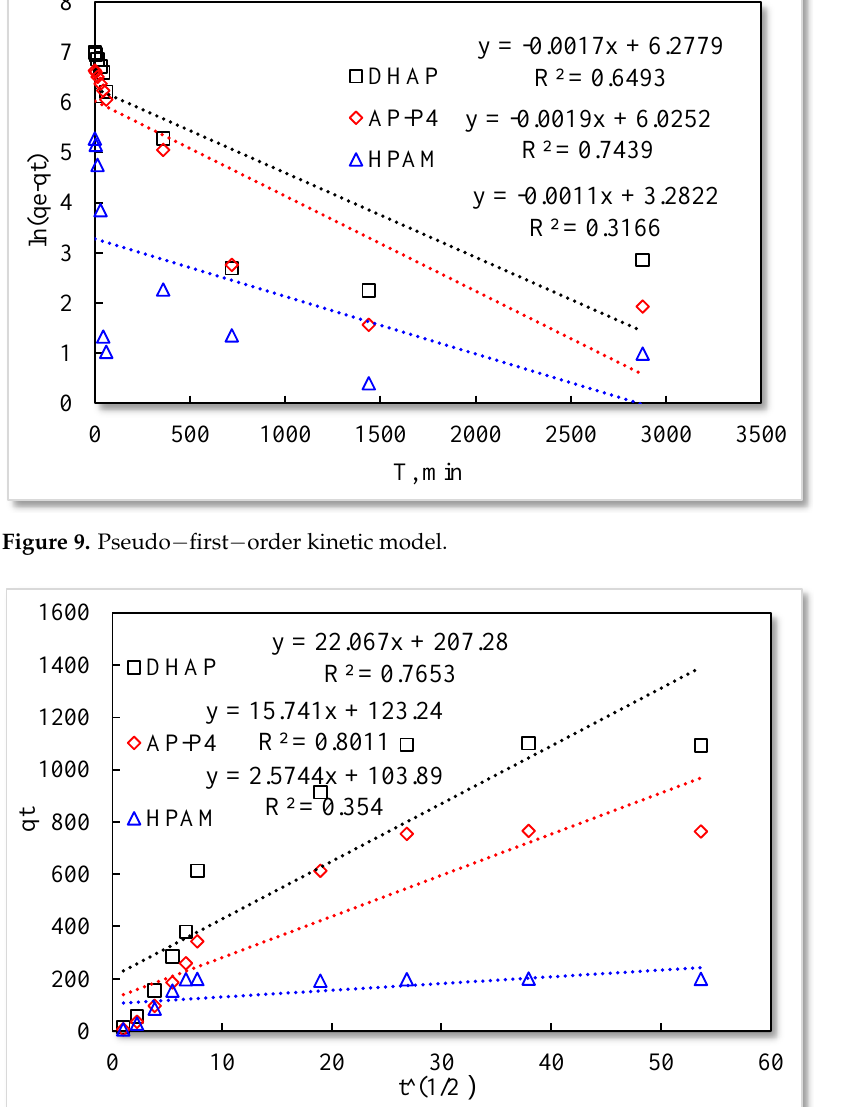
Figure 10. Particle diffusion model.